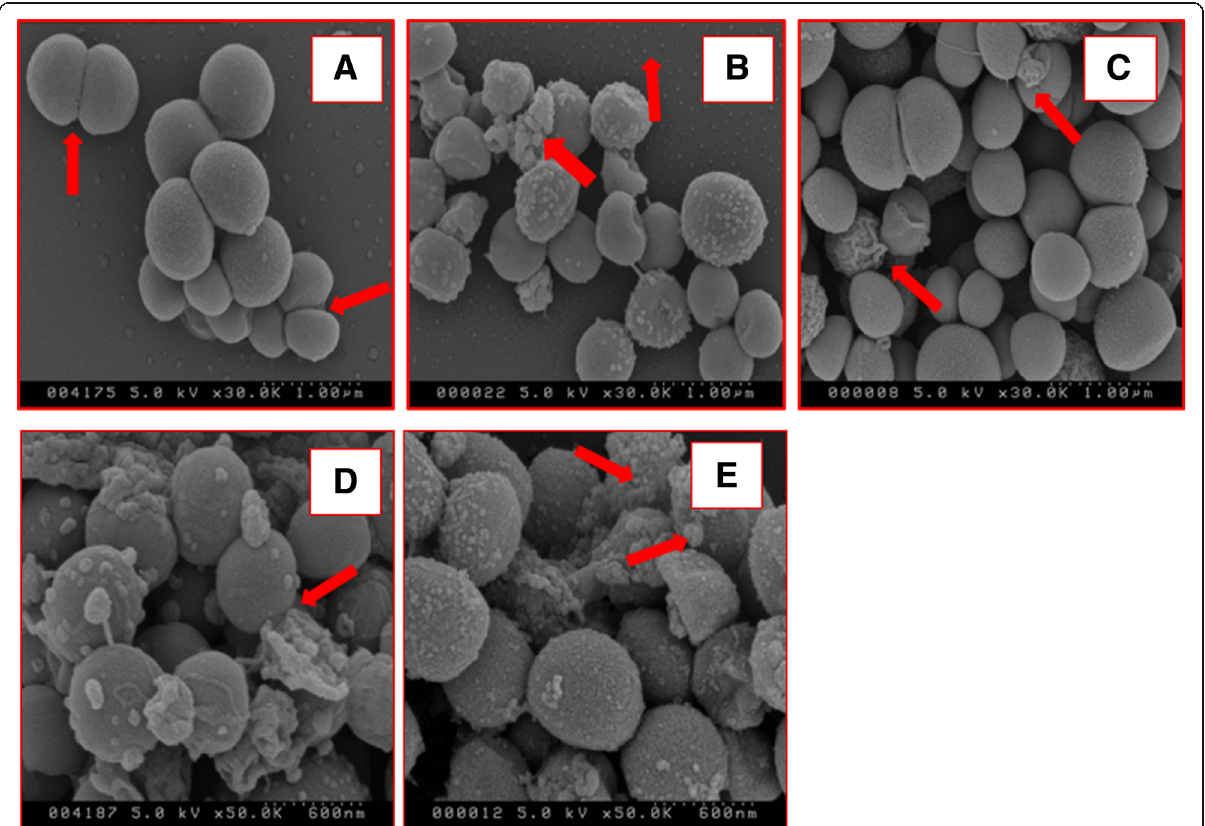
Fig. 2 Scanning electron micrographs (SEM) of S. aureus exposed to gallate derivatives. a ) Control SEM of S. aureus cells after exposure to 0.2% DMSO for 1 h with arrows pointing to cells undergoing binary fission. SEM of S. aureus cells after exposure to 2 × MIC level of b ) gallic acid ( 1 ), c ) ethyl gallate ( 6 ), d ) propan-2-yl 3,4,5-trihydroxybenzoate ( 8 ), and e ) 2-methylpropyl 3,4,5-trihydroxybenzoate ( 9 ). For panels B to E arrows point to apparent extrusion of cytoplasmic content from collapsed S.